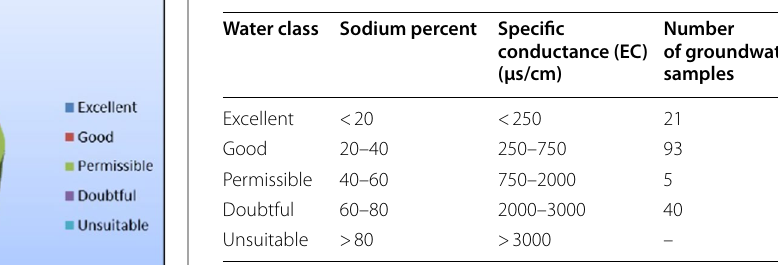
Table 14 Classification of irrigation water